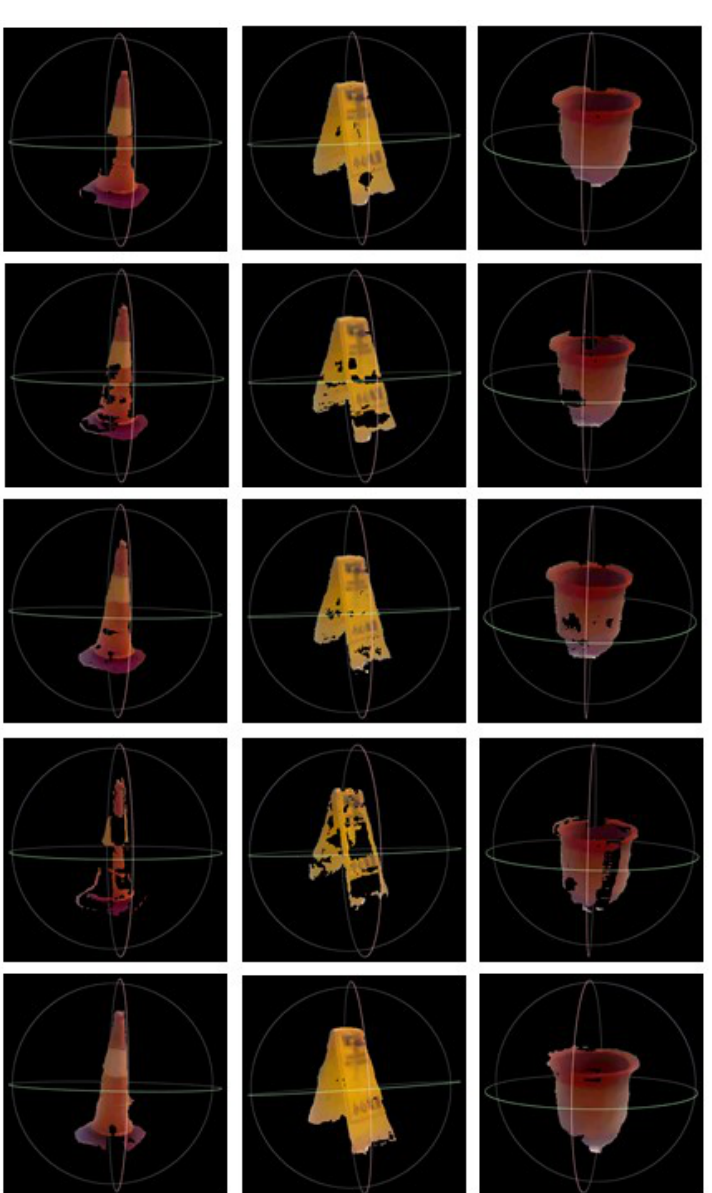
Figure 13. Comparison of 3D reconstruction of underwater targets using disparity maps provided by methods of AD-Census method, the FCVF method, the ARWR method, the SGM method and the proposed method, which are demonstrated from the first row to the last row, respectively.